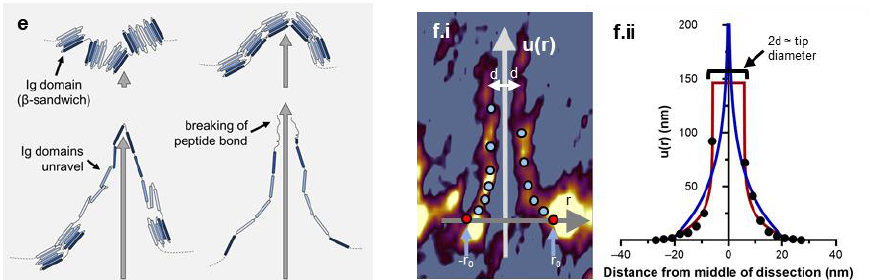
Figure 3. Nanosurgical manipulation of titin molecules. ( a.i ). Control AFM image of a titin oligomer prior to manipulation. Arrow shows the direction AFM tip movement with a speed of 10 nm/s. The bright section of the arrow indicates the area used for topographical height analysis. ( a.i.profile ). To- pographical height profile along the cross-section of a titin filament (shown in ( a.i )). ( a.ii ). Enlarged view of the AFM image of the manipulated titin oligomer. Red line indicates the area used for topographical height analysis. ( a.ii.profile ). Topographical height profile along the cross-section of a nanosurgically pulled titin filament (shown in ( a.ii )). The two height-profile maxima correspond to the two strands of the pulled titin loop. ( b.i ). Control AFM image of a titin oligomer prior to manipulation. Arrow shows the direction AFM tip movement with a speed of 1000 nm/s. ( b.ii ). AFM image of the manipulated titin oligomer. ( c. ) Effect of manipulation speed on titin filament structure. ( c.i , c.ii ). Enlarged AFM images of titin filaments pulled with speeds of 10 and 1000 nm/s, respec- tively. L 0 indicates the segment of titin that became stretched out. L 1 and L 2 indicate the strands of the pulled-out titin loop. ( c.iii ). Schematic model of the titin-segment nanosurgical manipulation with different speeds. ( d ). Distribution of the length of the titin-loop segments pulled out from single titin molecules. ( e ). Schematic steps of the molecular events underlying the stretching of the titin filament with nanosurgical manipulation. For the sake of simplicity, only five out of the seven ß-strands of titin’s domains are shown. ( f.i ) Enlarged view of a filament loop pulled out of titin with a superimposed coordinate system for analysis. The vertical arrow shows the position, direction, and length scale ( u ) of nanosurgical manipulation, the horizontal arrow is the tangent vector positioned on the starting point of the manipulation, r 0 is the radius of the initial loop, and d is the AFM tip radius so that 2 d is tip diameter. Circles mark the image points for distance measurements. ( f.ii ). Local loop extension ( u ) as a function of distance, along the original contour of titin, from the initial point of manipulation. Blue curve is the fit of the original thin-plate model to our data. For fitting, the coefficients P x (applied force), E (Young’s modulus) and v (Poisson ratio) were merged in a single coefficient k according to equation 3. We note that the model can be used if the shape of the displacement is nearly symmetrical to the y